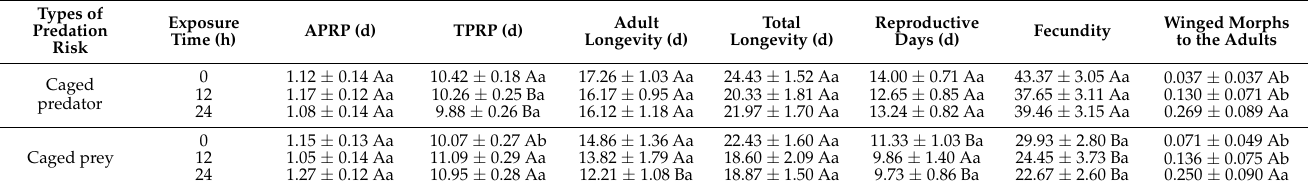
Table 3. The effects of the predation risks on the adult pre-reproductive period (APRP), total pre- reproductive period (TPRP), longevity, and fecundity of Sitobion miscanthi . Values are presented by the mean ±